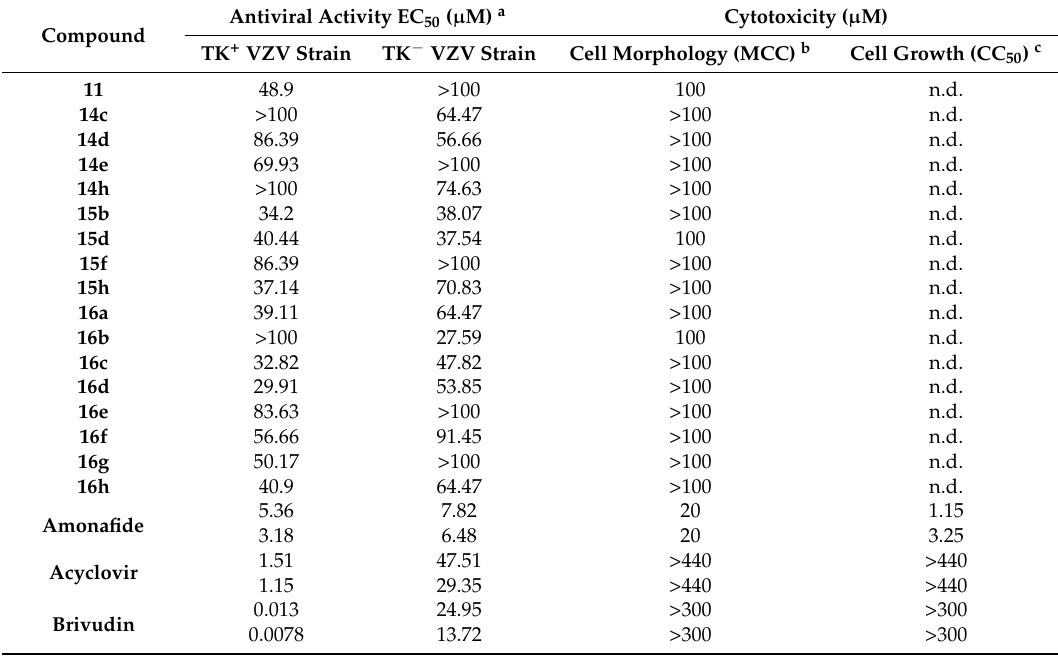
Table 1. The antiviral activity and cytotoxicity against varicella-zoster virus (VZV) in HEL cell cultures.